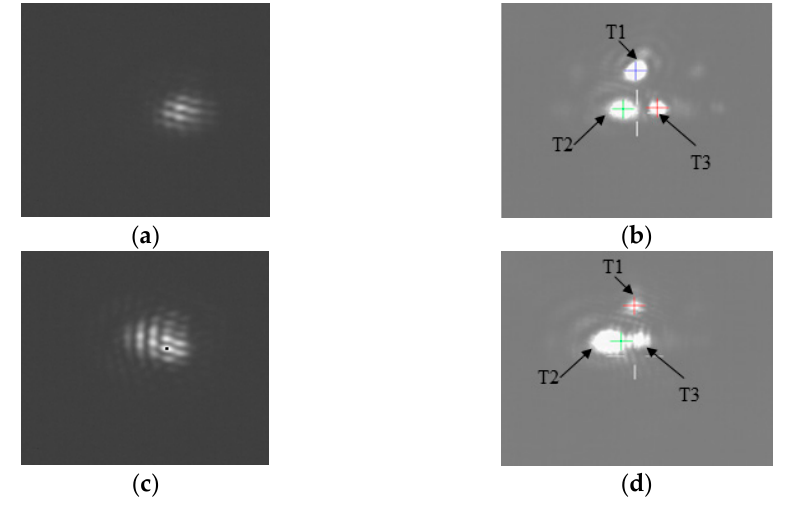
Figure 6. Imaging results obtained from the focal plane detector and the defocus plane detector at different pointing positions; the images were taken from the position of P3 at the ( a ) focal plane and ( b ) defocus plane and the position of P12 at the ( c ) focal plane and ( d ) defocus plane.